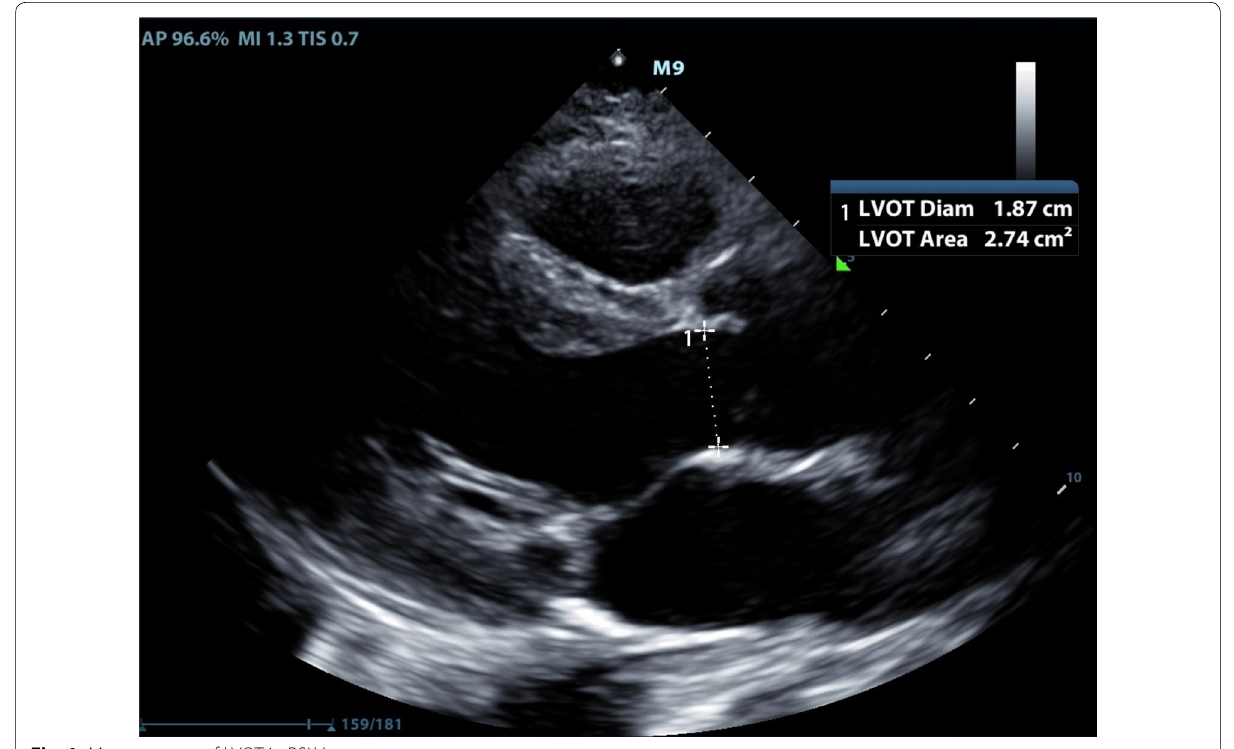
Fig. 1 Measurement of LVOT in